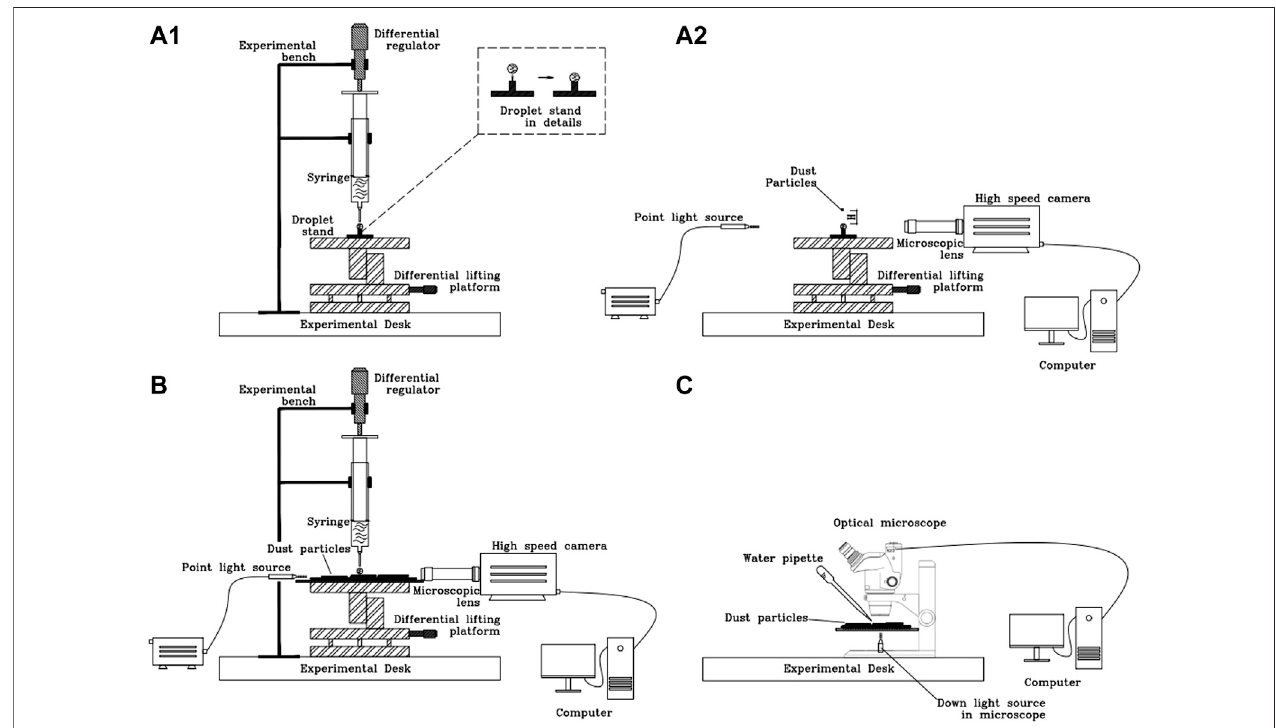
FIGURE 1 | Schematic illustration of experimental apparatus (A1) droplet set up on a stand and (A2) dust and water droplet contacting experiment recorded by high-speed camera; (B) water droplets were sprayed on the stationary dust particles, to record the contacting and adsorption characteristics; (C) water droplets were droppedtothestationarydustparticleslayer,theopticalmicroscopewasusedtorecordtheagglomerationcharacteristicsofdustparticleswhendifferentwaterdroplets sprayed.